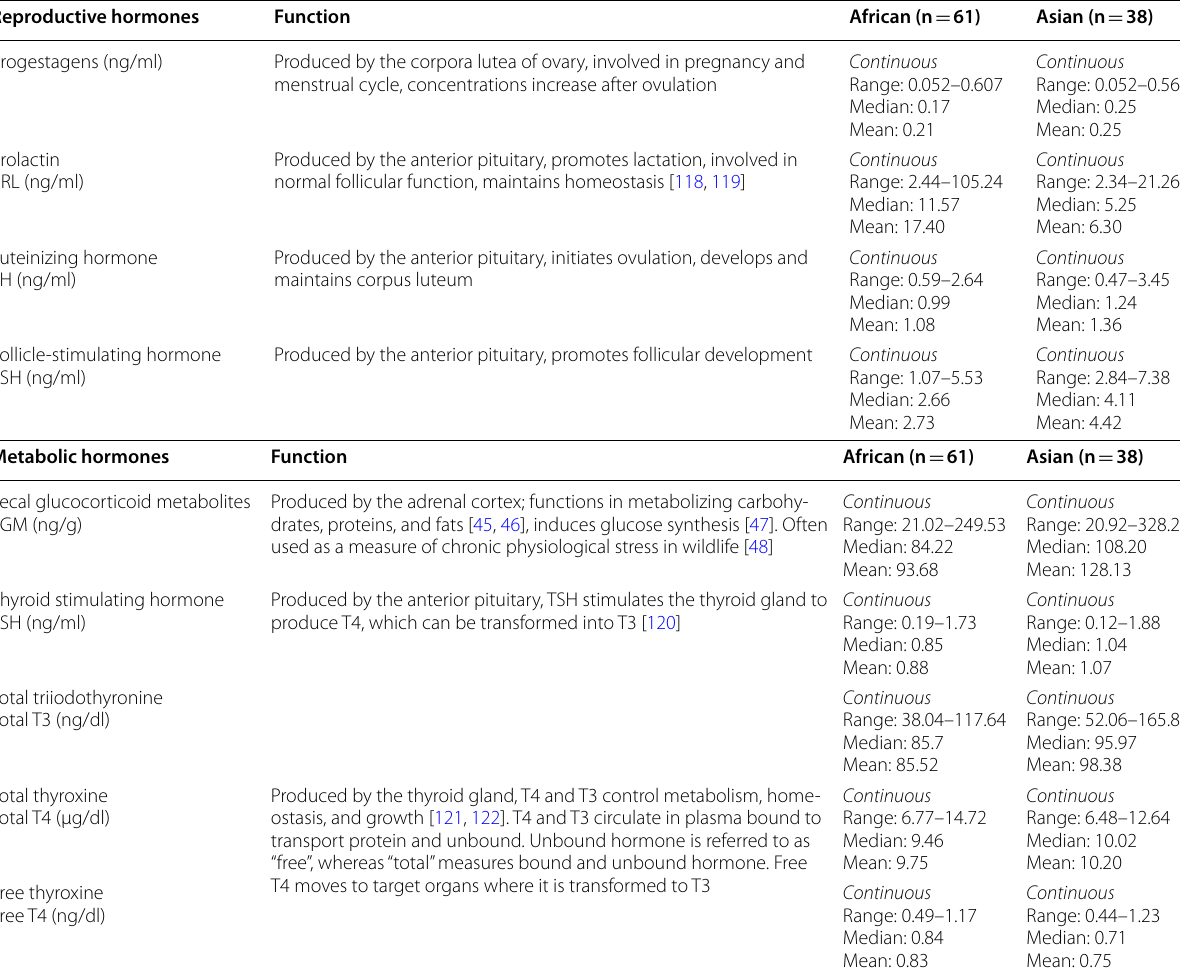
Description of general function and range of reproductive and metabolic hormones in African and Asian elephants (dataset includes zoos with two or more elephants)